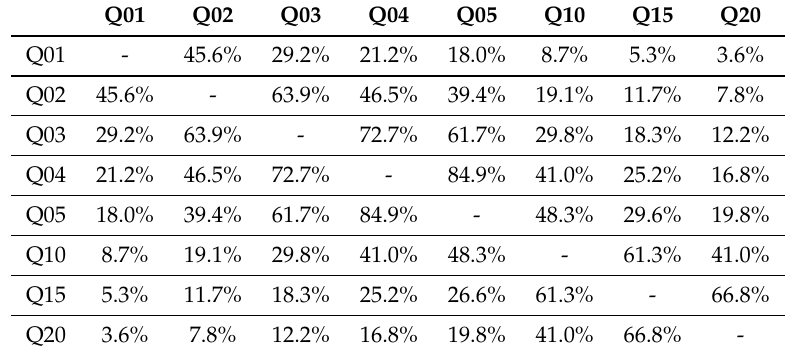
Table 4. Percentage of the larger file representing the smaller file with content in plain text format.